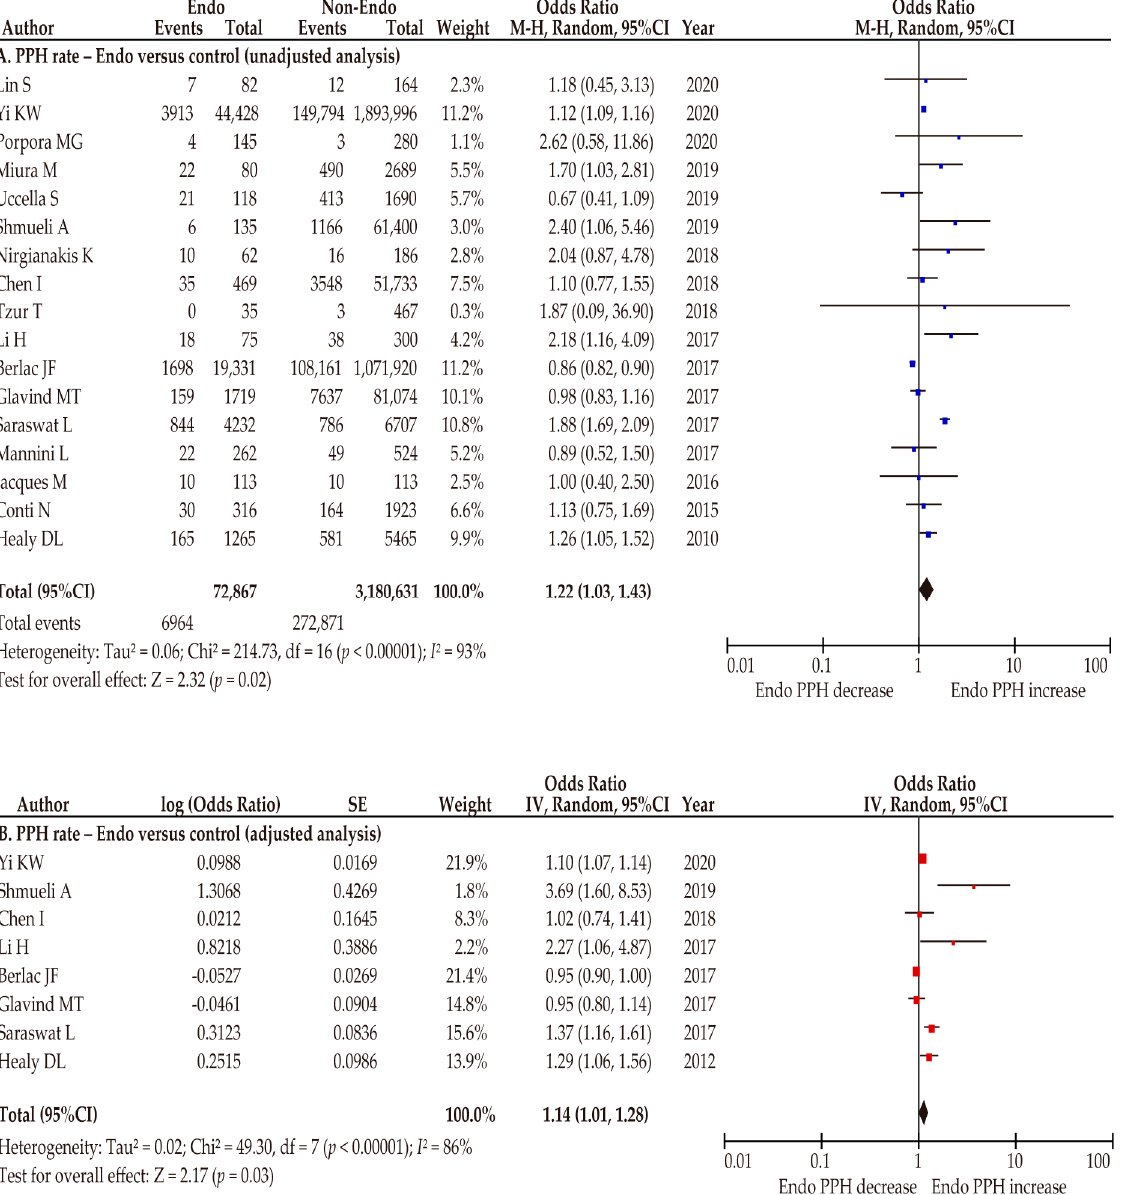
Figure 6. Meta-analysis of the effect of endometriosis on the rate of postpartum hemorrhage. The pooled unadjusted ( A ) and adjusted ( B ) odds ratios for postpartum hemorrhage between women with and without endometriosis are shown. The forest plots were modified within the stratum according to year of publication and relative weight (%) of the study. Heterogeneity was considerable in both analyses (( A ), I 2 = 93%; ( B ), I 2 = 86%). Some values listed might differ slightly from the original values because the calculation was performed using Revman v5.4.1. Abbreviations: CI, confidence interval; Endo, endometriosis; PPH, postpartum